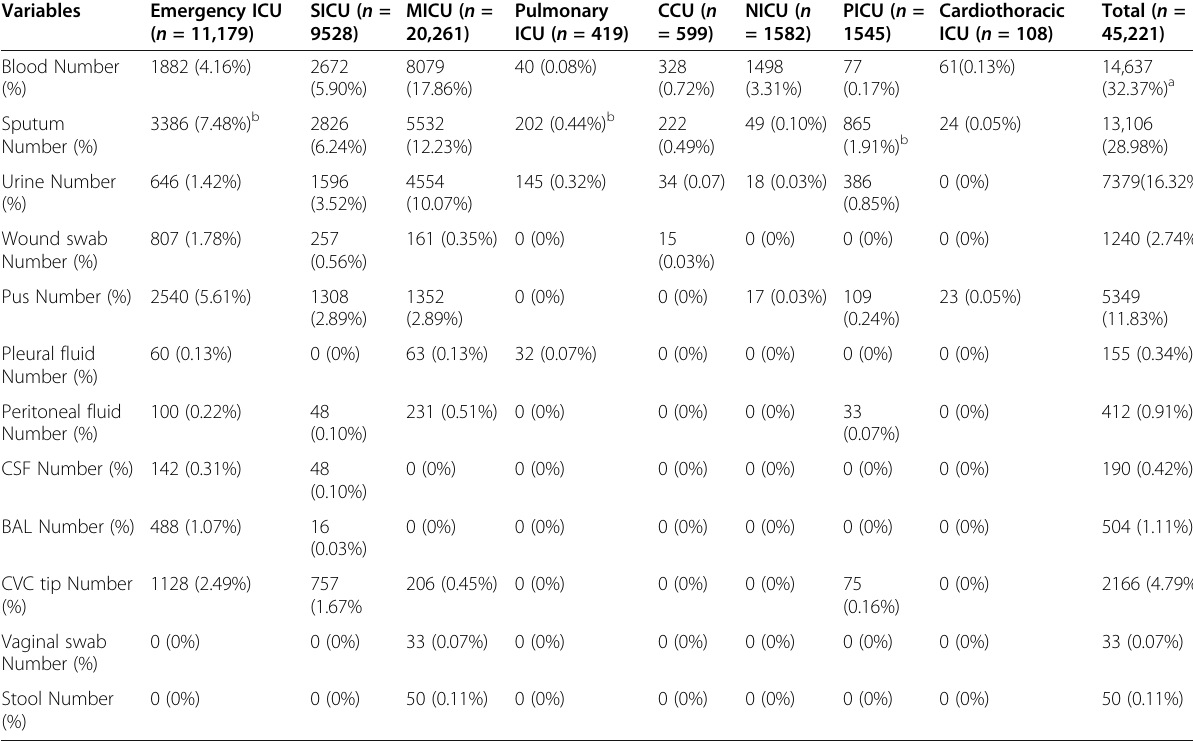
Table 1 Prevalence of positive samples in different ICUs